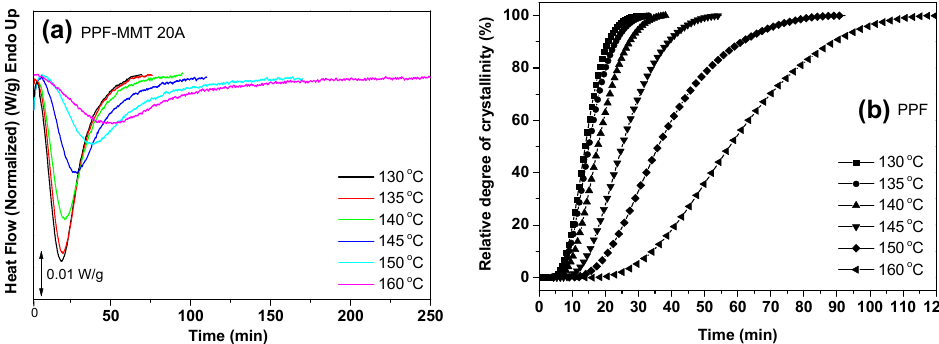
Figure 5. ( a ) Isothermal crystallization peaks recorded at different crystallization temperatures, for the PPF-MMT sample ( b ) evolution of the relative degree of crystallinity versus time for the PPF sample.